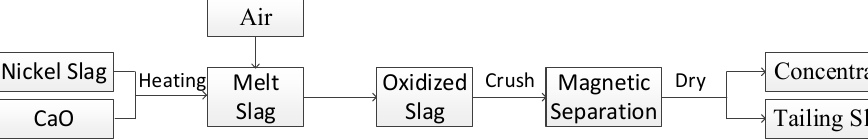
Figure 2. The flowsheet of the oxidation and separation process.